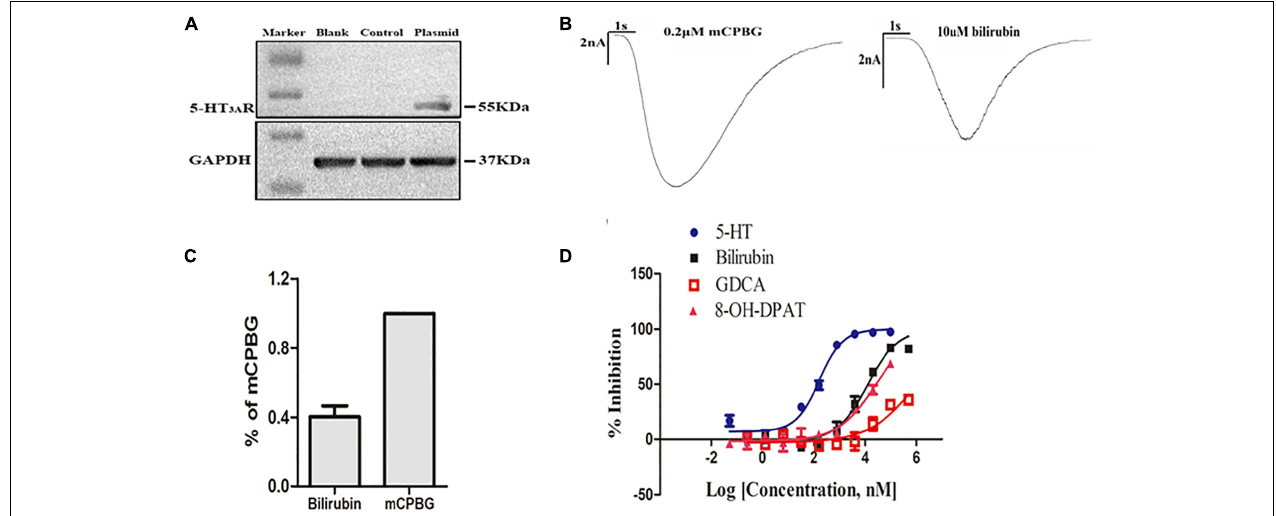
FIGURE 3 | Bilirubin directly activated the 5-HT 3 A receptor with low affinity. (A) Western blot analysis showed the establishment of HEK293 cells overexpressing the human